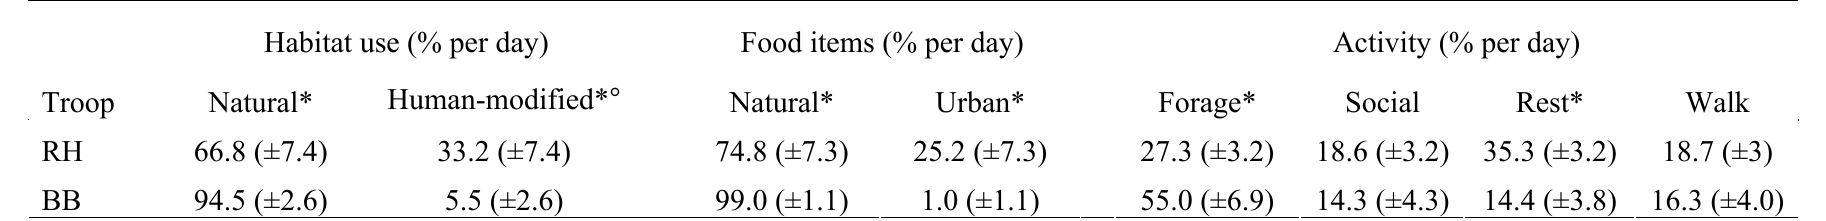
Table A. Mean daily percentage (±SEM) of habitat use, diet and activity budgets of two equal-sized troops (RH and BB) during winter ( n =10 days). * indicate significant differences at p